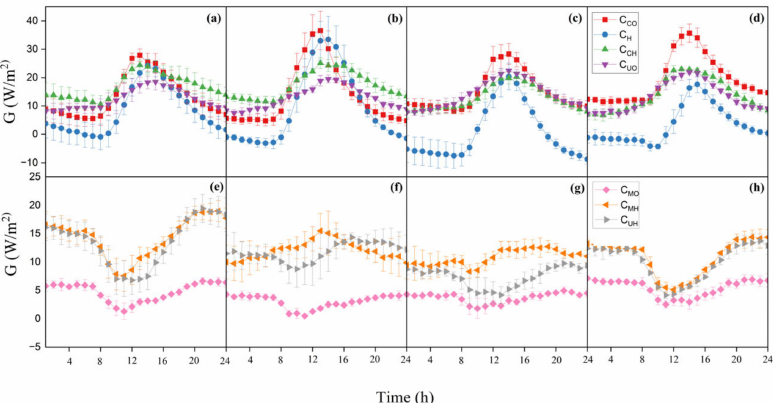
Figure 4. Diurnal variations in soil heat fluxes ( G ) in seven riparian communities, in spring ( a , e ), summer ( b , f ), autumn ( c , g ) and winter ( d , h ). The bars show the standard